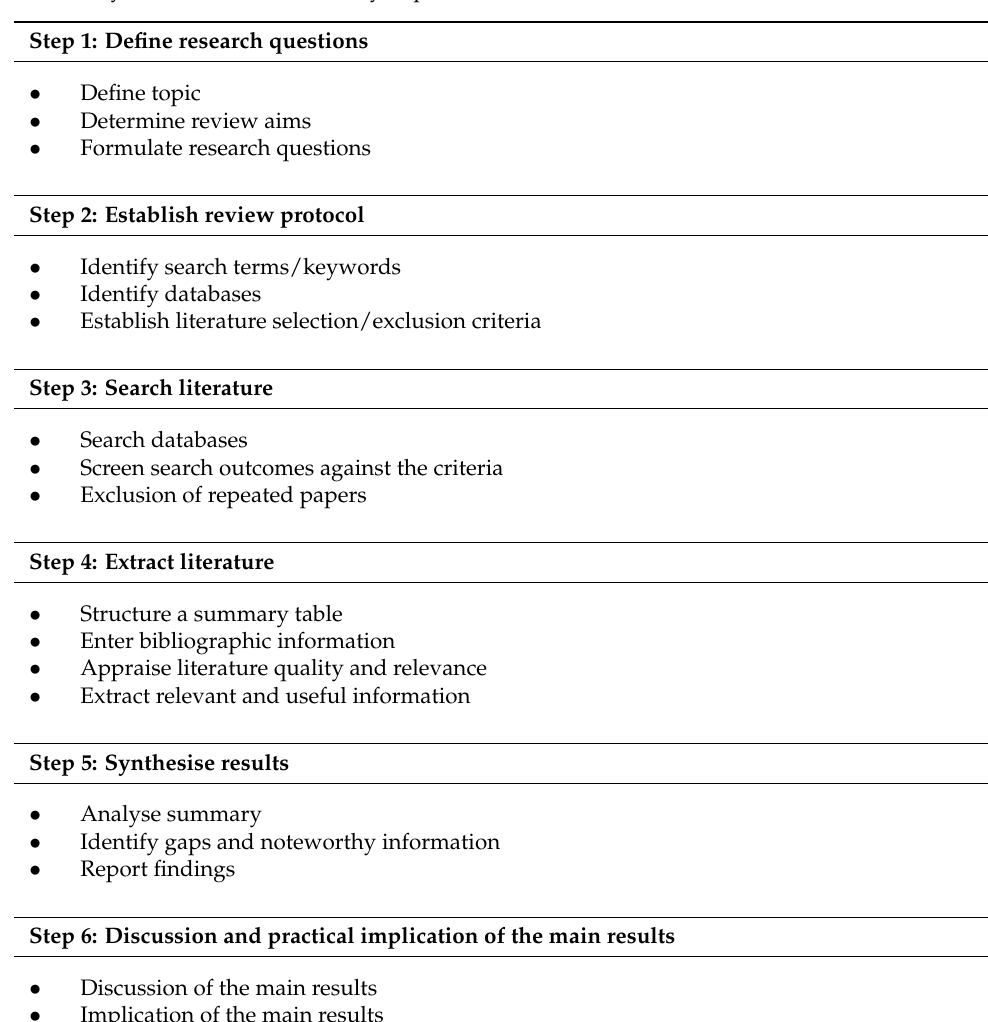
Table 1. Systematic review and analysis